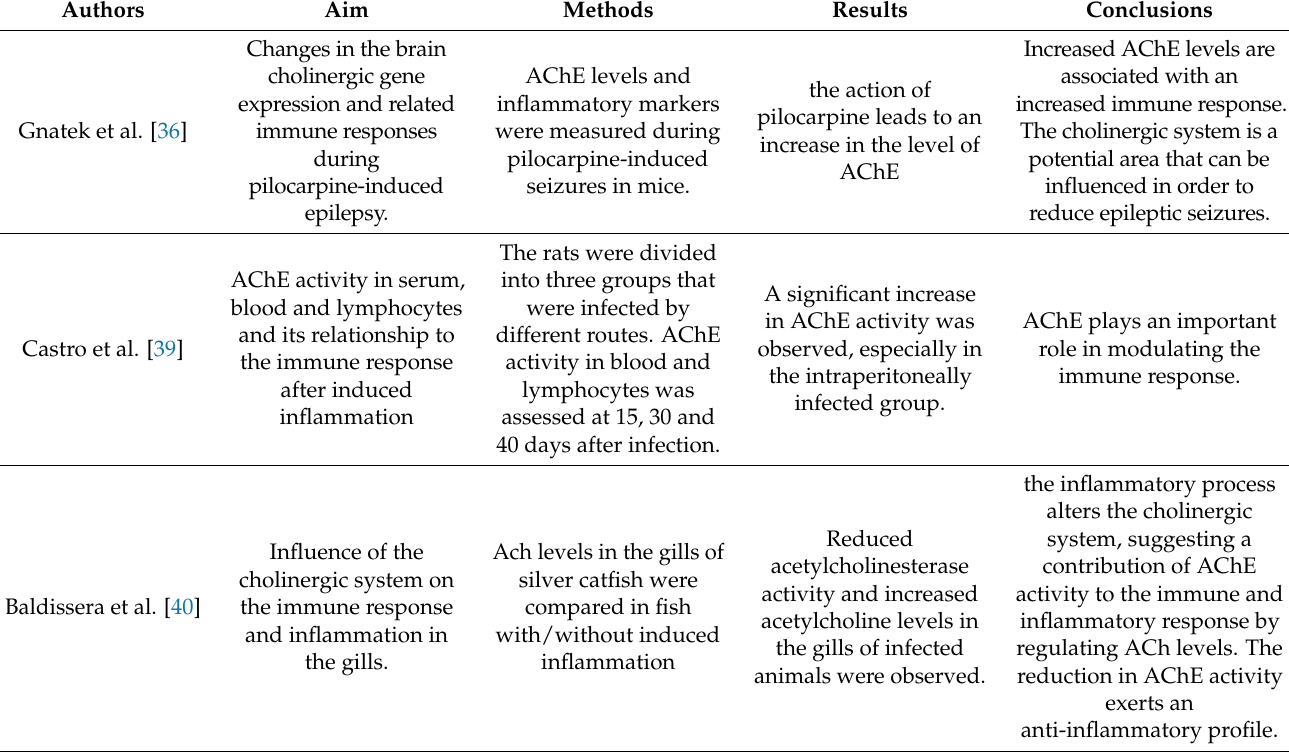
Table 2. Acetylcholinesterase and inflammatory